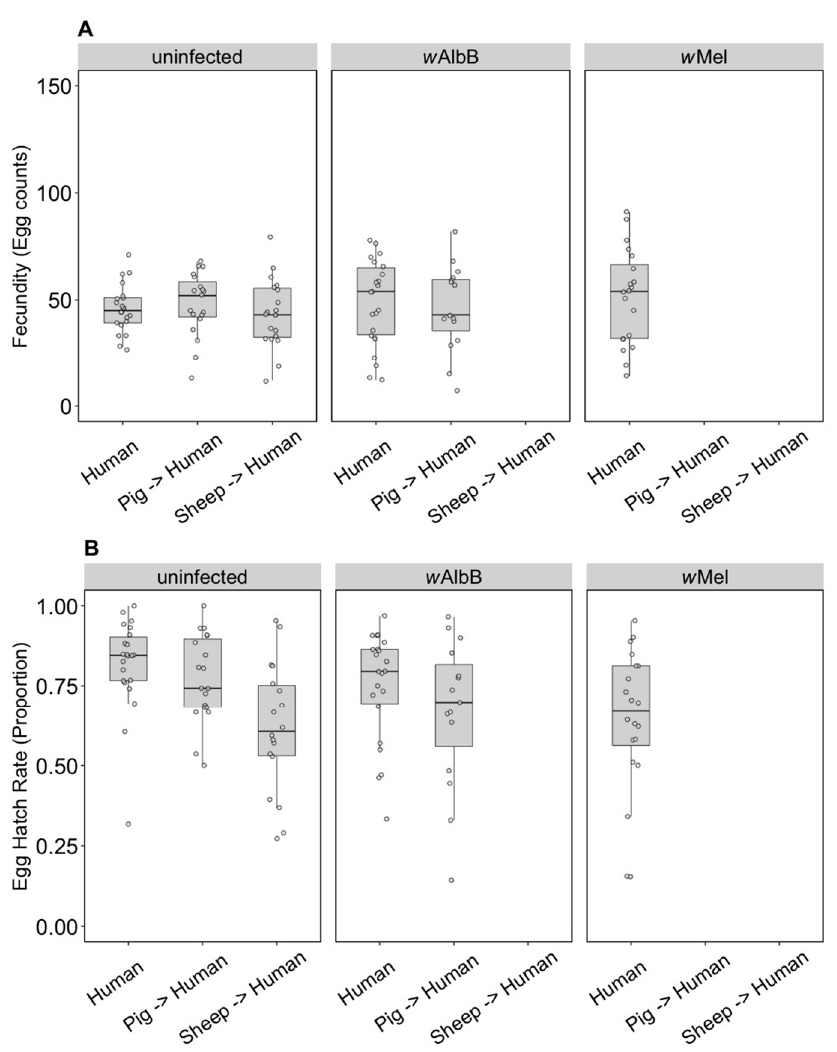
Figure 7. Comparison of fecundity and egg hatch rates across infection types (uninfected, w Mel, w AlbB) when females were fed on human blood after colonies were maintained on different blood sources for 10 generations (human, pig, sheep). Some of these groups lost their infection during maintenance; therefore, no comparison is possible for w AlbB and w Mel-infected groups fed on sheep blood. There is also no w Mel-infected group maintained on pig blood. ( A ) Fecundity (egg counts); ( B ) egg hatch rate (proportion). Each dot embodies the egg count and egg hatch rate of an individual female. The boxplots represent the first to the third quartiles around the median (horizontal grey line) and the vertical bars represent the 1.5 interquartile of the lower and upper quartiles. Around 15–24 females per blood source and generation were tested.